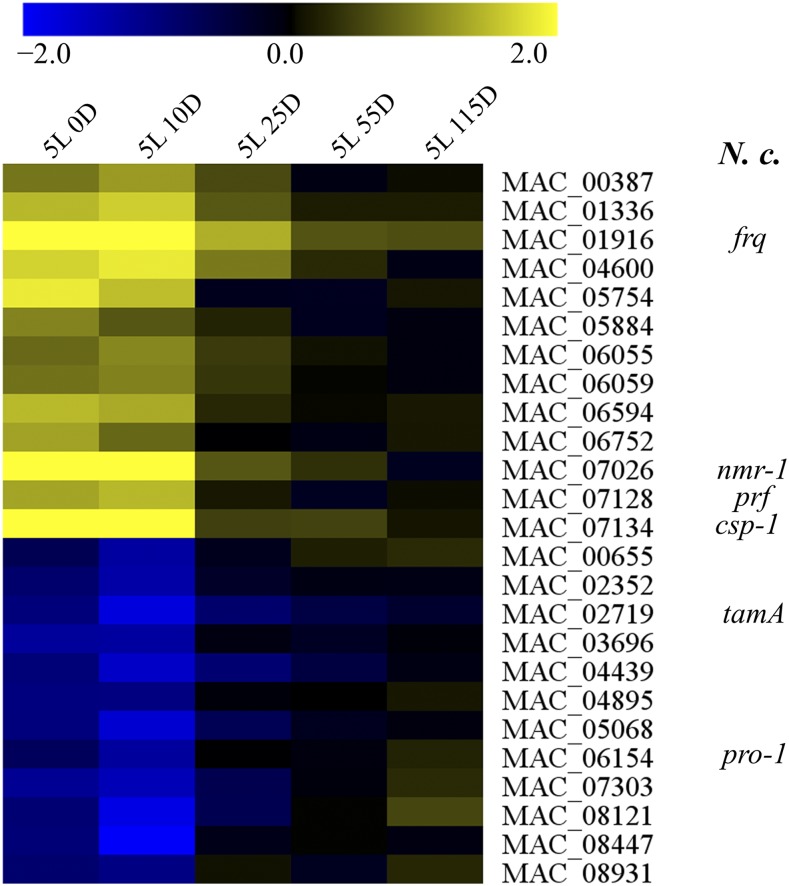
Heat map depicting the early regulation of genes coding for transcriptional regulators on clusters C2 and C8. Transcriptional regulator activity was according to Gene Ontology. Values in scale bar are log2 fold-change relative to DD. N . c. = Neurospora crassa known homolog genes.